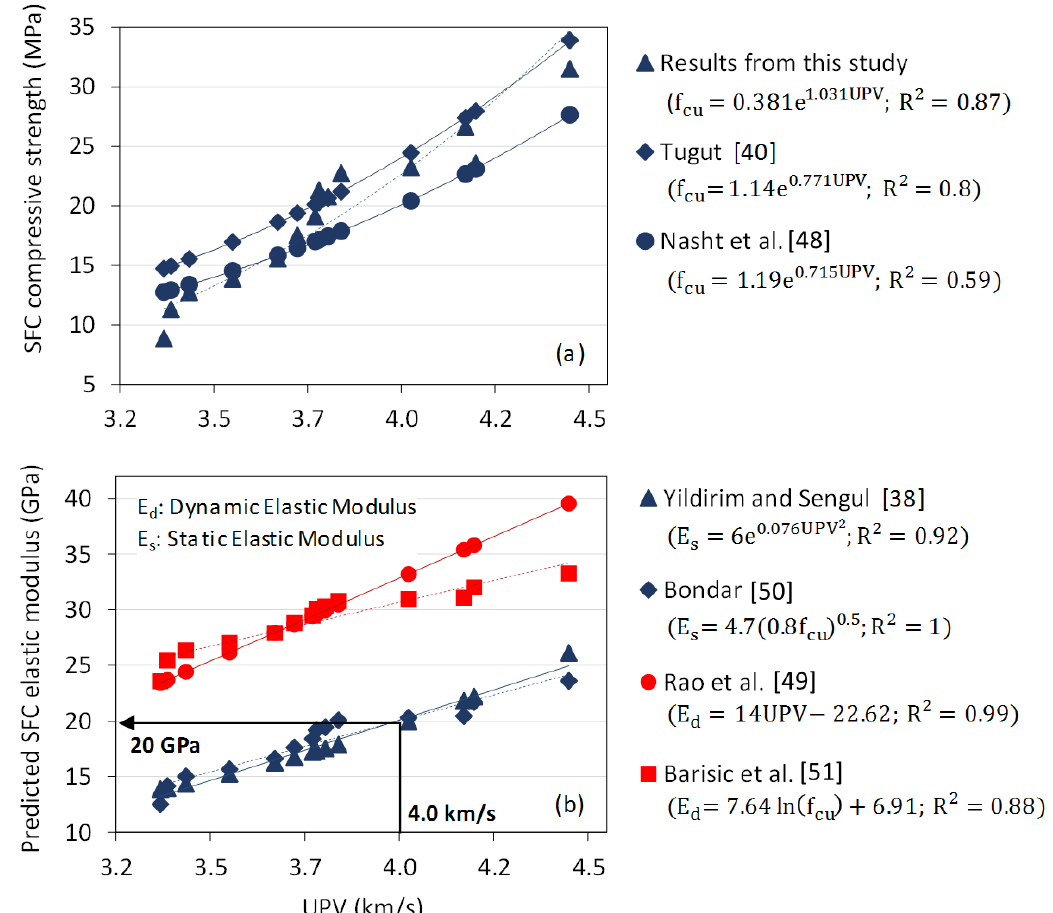
Figure 5. ( a ) Relationships between ultrasonic pulse velocity and compressive strength for both measured and published data (for Portland cement concrete); ( b ) Relationships between ultrasonic pulse velocity and both static and dynamic elastic modulus for published data (for Portland cement concrete).